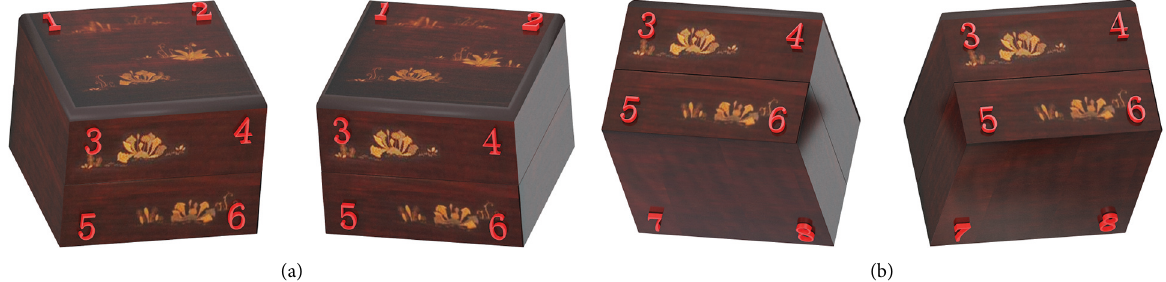
Figure 7: Shooting results at two locations. (a) Position A. (b) Position